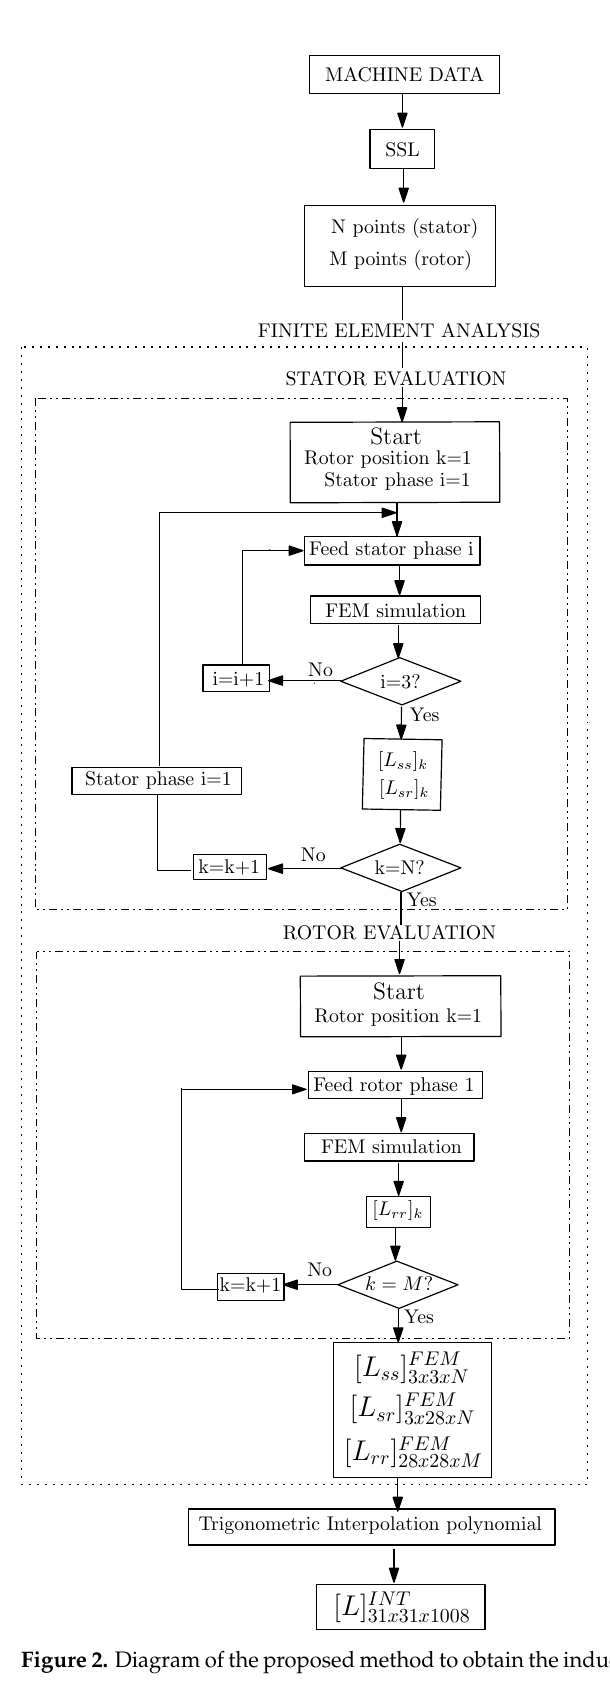
Figure 2. Diagram of the proposed method to obtain the inductance matrix of an IM model using FEM- based software and sparse subspace combined to trigonometric interpolation polynomial